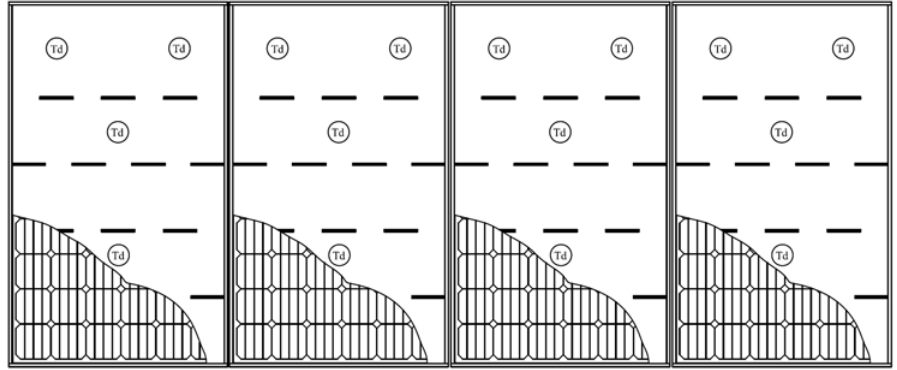
Figure 8. Thermocouple position for the PV temperature measured at the four PVT collectors installed in the experimental